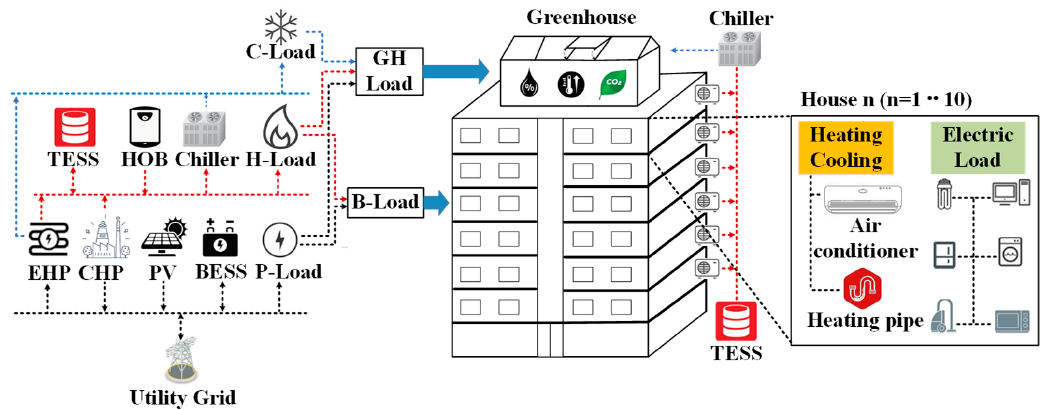
Figure 1. Building microgrid configuration.